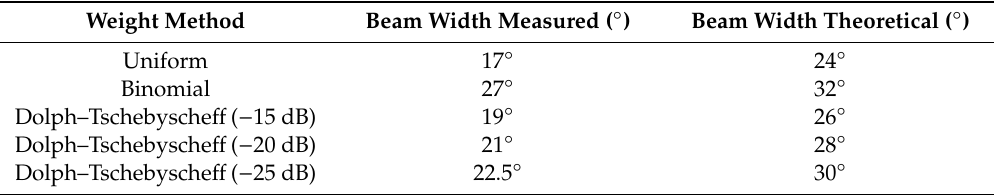
Table 3. Half power beam width (HPBW), measured and simulated.